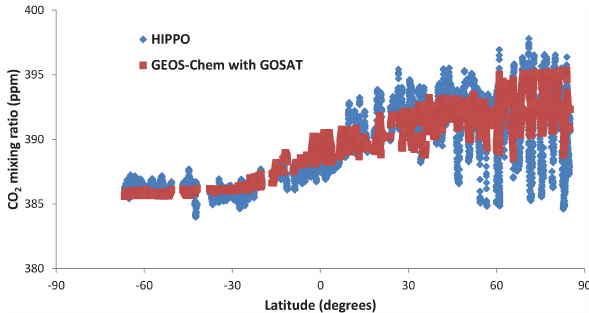
Figure 2. Comparison of modeled a posteriori CO 2 mixing ratios in the upper troposphere from our GOSAT inversion analysis (in red) with HIPPO observations (in blue) between 70 ◦ S to 84 ◦ N and above 5000m in altitude. These a posteriori CO 2 fields are from the inversion denoted as our standard